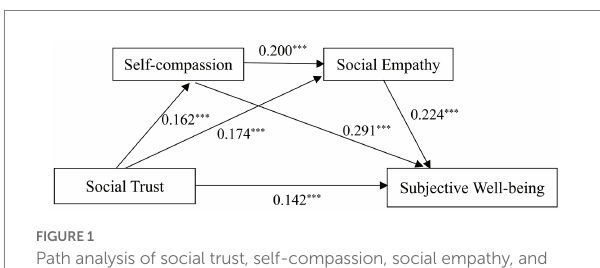
FIGURE 1 Path analysis of social trust, self-compassion, social empathy, and subjective well-being. *** p <